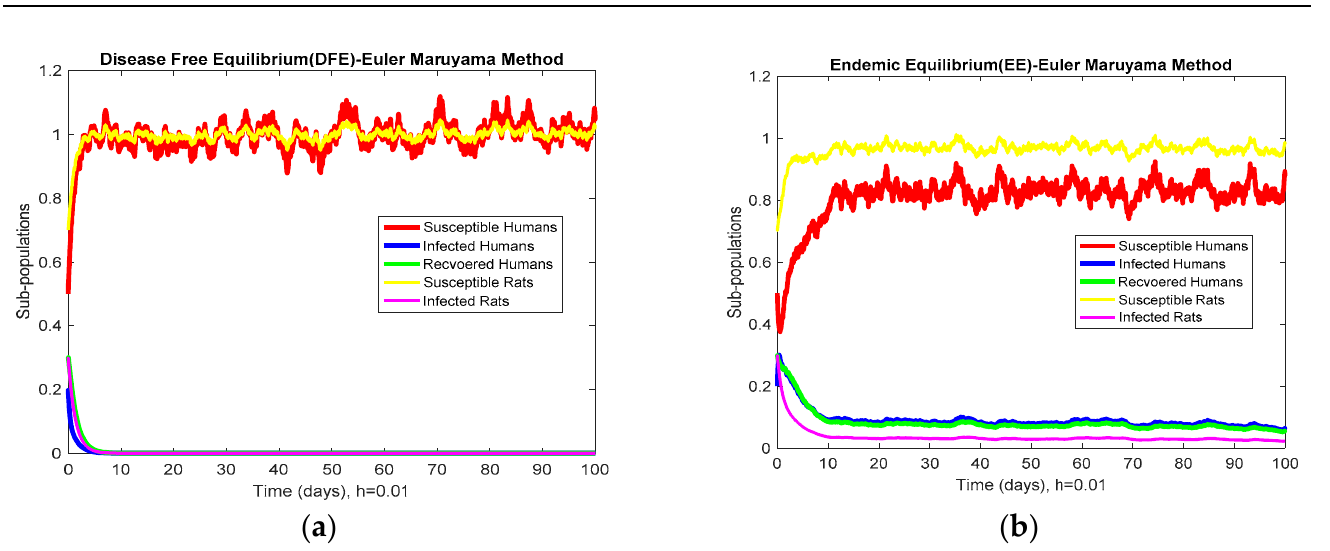
Figure 2. Depicts the graphical behavior of the system (8) through the Euler–Maruyama method with the help of stochastic differential equations (SDEs) package. ( a ) The behavior of each subpopulation for disease-free equilibrium at h = 0.01. ( b ) The behavior of each subpopulation for endemic equilibrium at h = 0.01 .